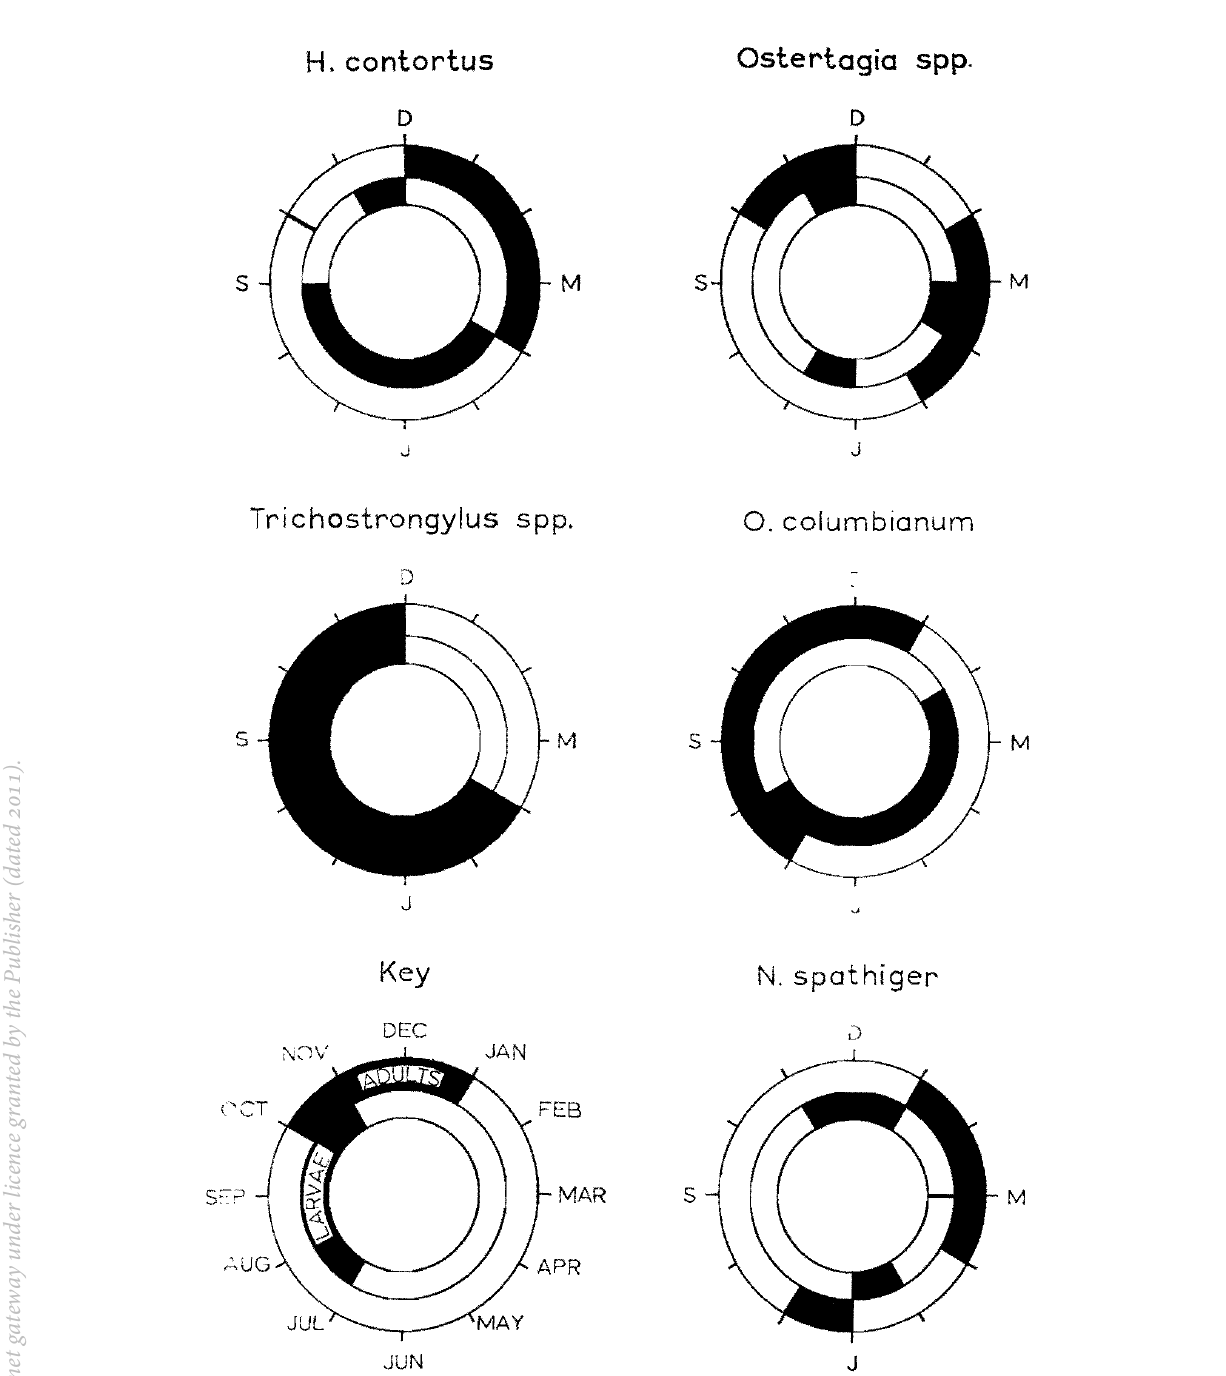
Fig. I.-Correlation of autopsy results of Rossiter (1964)19, Barrow (\964)1 and Viljoen (1964)29 showing the months when adults and larvae were most numerous. All species were present throughout the year and blank spaces do not indicate the complete absence of any species or